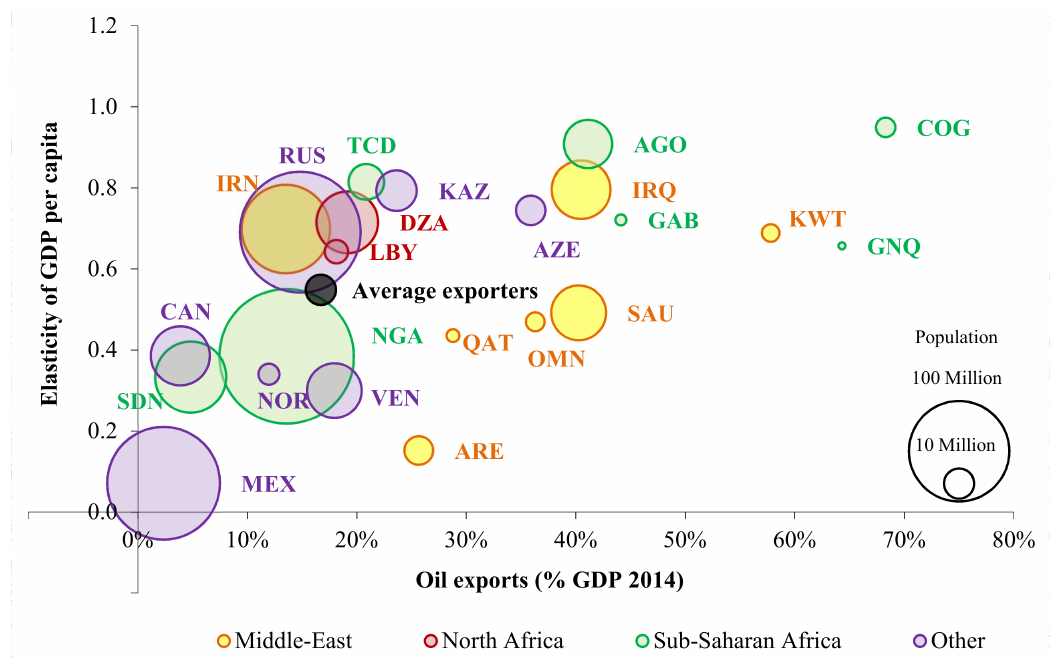
Figure 7. Elasticity of GDP per capita to oil price (1990–2014). Size of the bubbles indicates population size in 2014. GDP per capita and oil price are expressed in current USD. Data source: oil price [19], oil exports [19,20], GDP [25], and population [21].